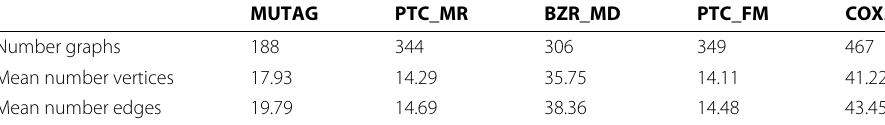
Table 1 Summary statistics for each dataset used in the